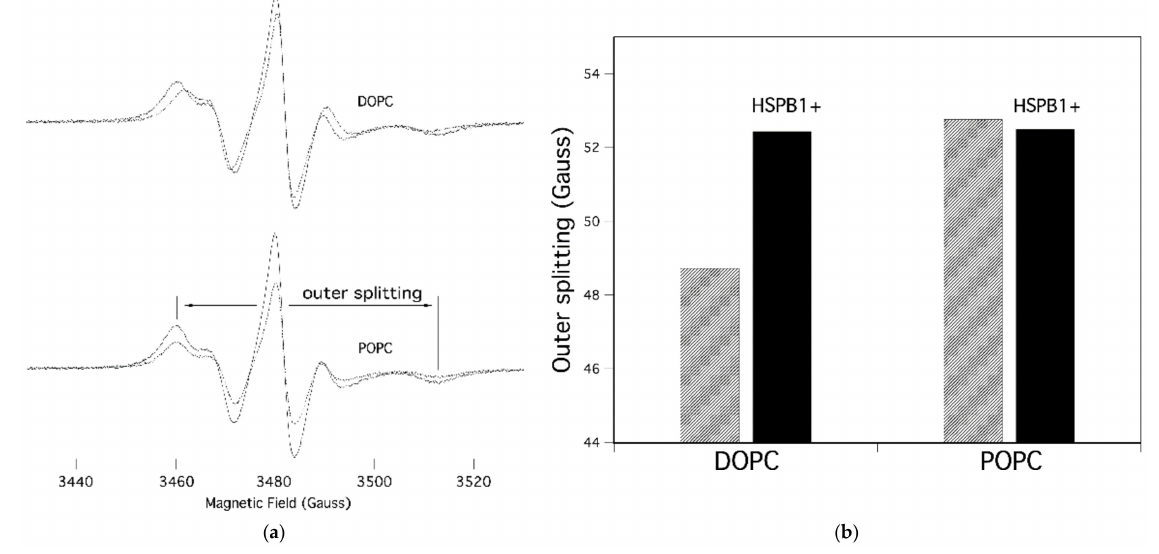
Figure 2. EPR spectra of 5-SASL in different lipid vesicles. ( a ) Spectra measured in the absence (dashed line) and in the presence (solid line) of HSPB1 (lipid to protein ratio, 100:1) are shown together. Spectral parameter outer splitting (2A max ) is indicated. ( b ) Outer splitting (2A max ) values of the control (striped) and HSPB1-containing (black) samples in different lipid